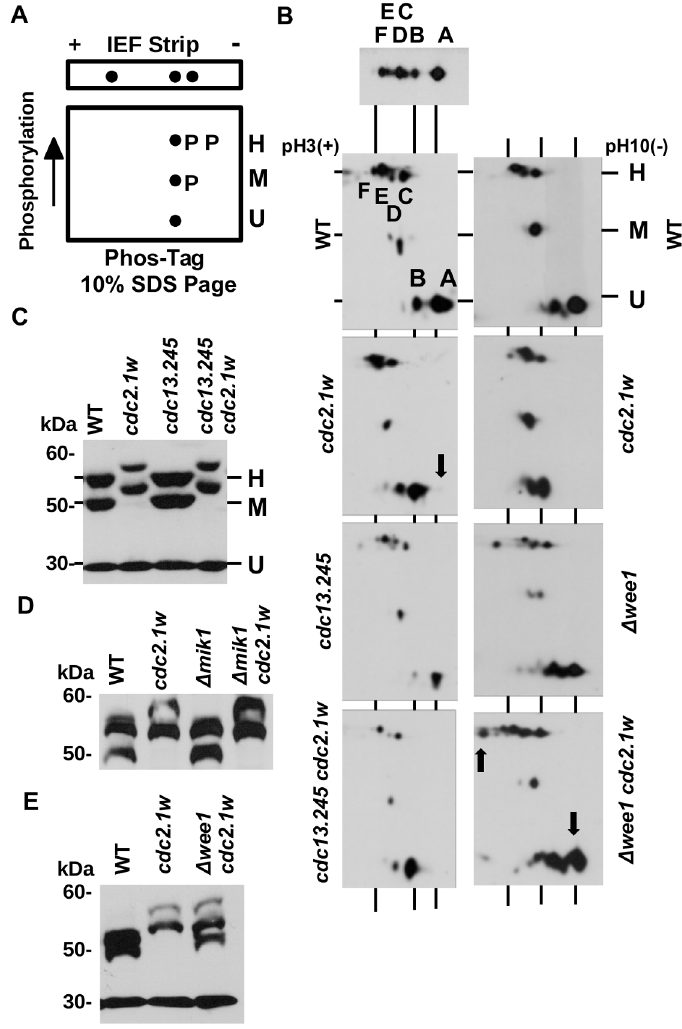
Fig 2. Wee1 kinase contributes to the aberrant modification of Cdc2.1w. (A) IEFPT analysis: IEF strips were placed on top of a 10% Phos-tag SDS page. The IEF strip separates Cdc2 by its isoelectric values and the Phos-tag SDS page by its degree of phosphorylation. (B) IEFPT analysis of total extracts prepared from the indicated strains. The mobility of the Cdc2 bands H, M and U is indicated. The top panel shows an example of the normal IEF pattern of wild type cells. The two wild type and cdc2 . 1w experiments were conducted independently. The arrows indicate the acidic shift of forms A and B in the cdc2 . 1w mutant, its reversal in the cdc2 . 1w Δ wee1 strain, and the additional, highly phosphorylated species in the H range in the cdc2 . 1w Δ wee1 strain. (C-E) Phos-tag analysis of total protein extracts prepared from the indicated